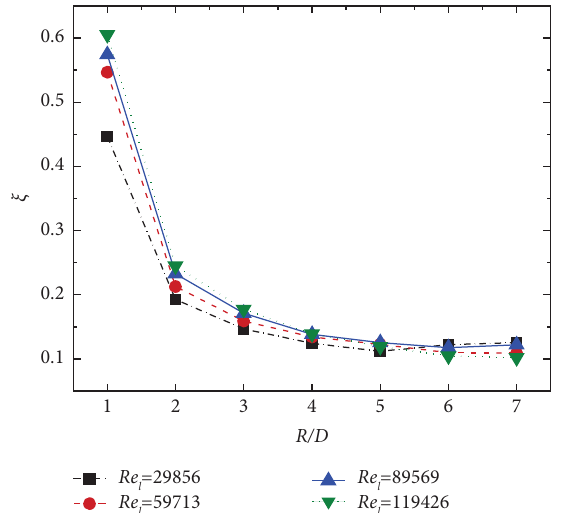
Figure 9: Relationship curves of ξ with R/D under diferent Re vertical L-shaped pipes.